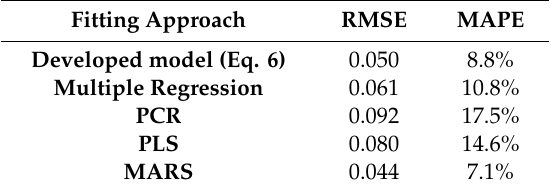
Table 1. Comparison of the RMSE and MAPE for di ff erent fitting